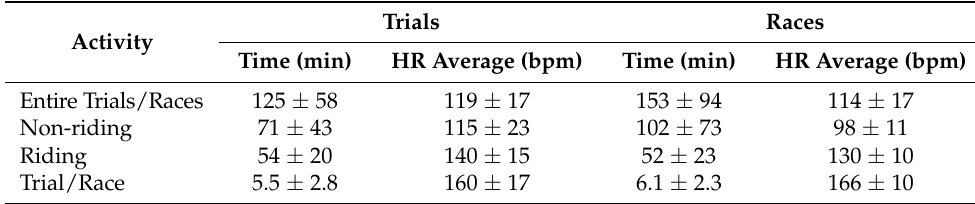
Table 2. Time allocation and HR (mean ± SD) during a day at the trials ( n = 10) or races ( n = 4) for 12